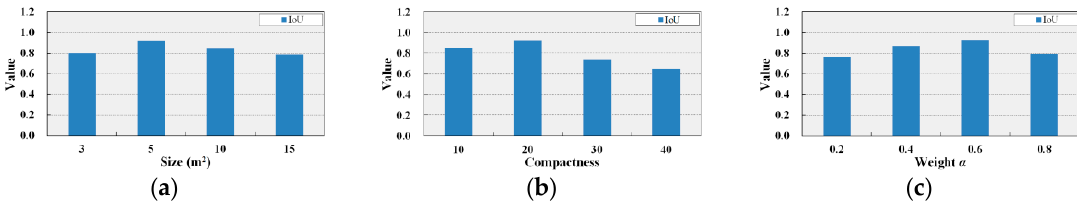
Figure 19. Comparison of the IoU values with different initial sizes, compactness of superpixels, and weight of height.